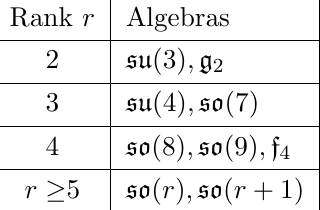
Table 1. Rank preserving tunings: tunings of these four classes of gauge algebras do not change h 1 ; 1 or h 2 ; 1